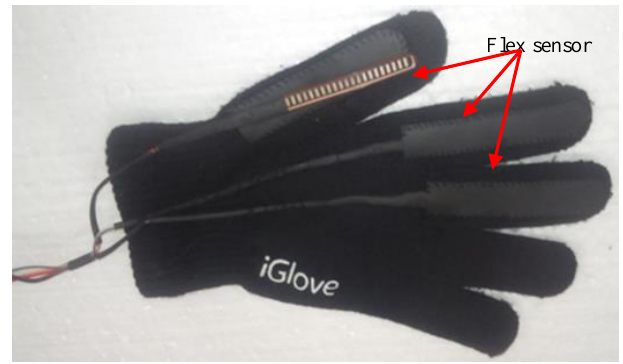
Figure 3. Developed glove sensor for extra robotic finger input.